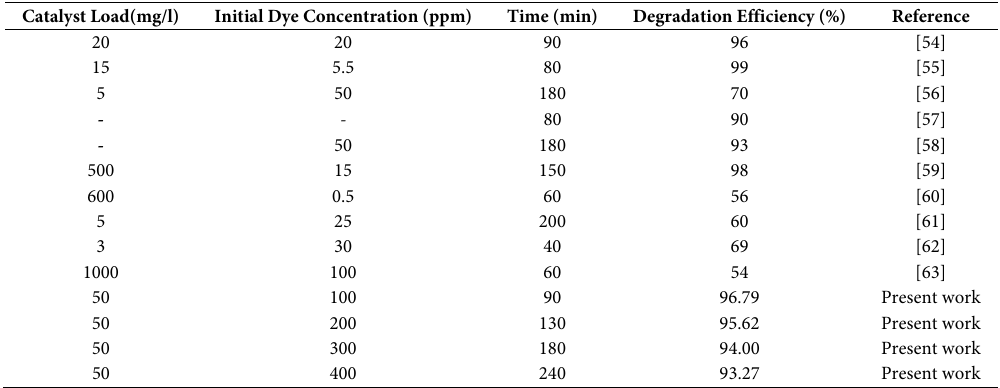
Table 5. Comparison of literature work with current Catalyst Load(mg/l) Initial Dye Concentration (ppm)